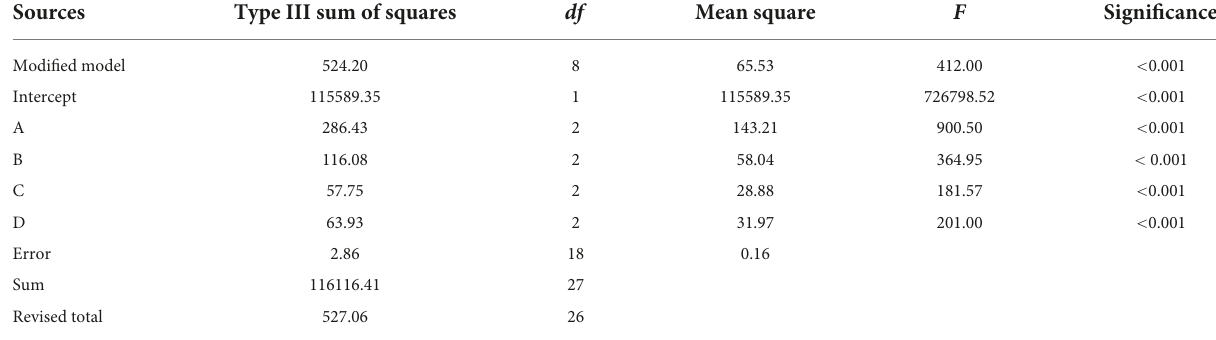
TABLE 3 Analysis of orthogonal experimental